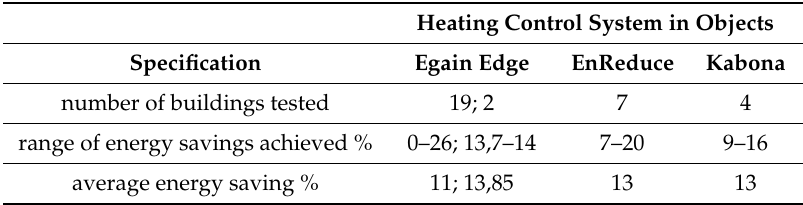
Table 1. Comparison of energy saving levels for di ff erent control systems for central heating in residential